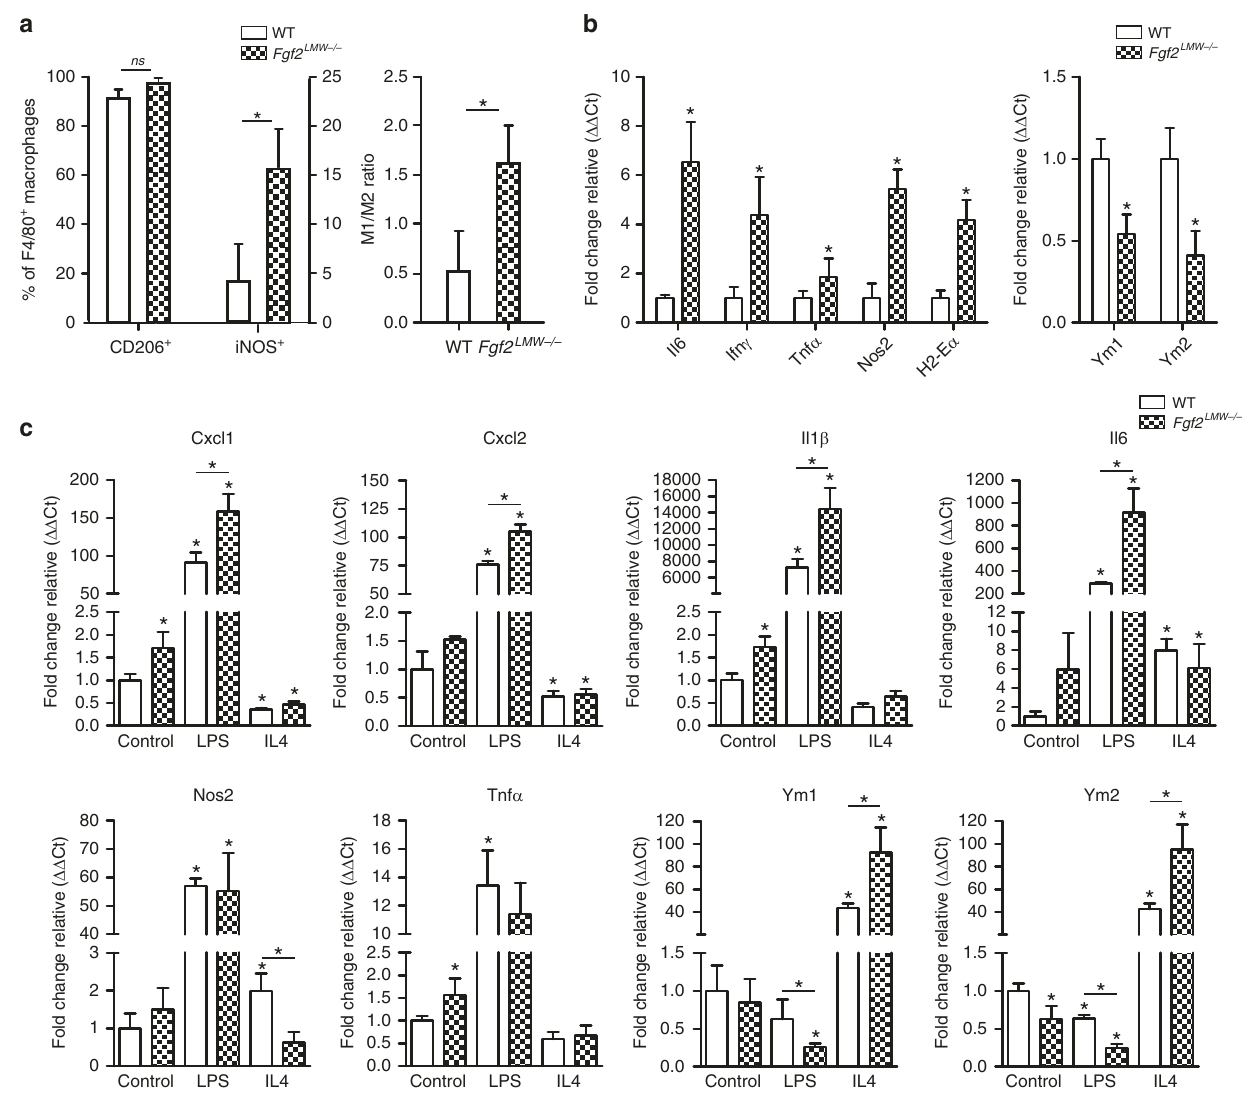
Fig. 4 Fgf2 LMW − / − macrophages are polarised towards an M1 phenotype. a Macrophage analysis of iNOS and CD206 in WT ( n = 6) and Fgf2 LMW − / − ( n = 9) mice 10 days post-tumour cell injection using fl ow cytometry. b RNA expression analysis of macrophages isolated from subcutaneous tumours of WT and Fgf2 LMW − / − mice 10 days post-tumour cell injection. c RNA expression in WT and Fgf2 LMW − / − BMDM following stimulation with LPS or IL4 using qRT- PCR analysis; Cxcl1 , Cxcl2 , Il1 β , Il6 , iNOS , Tnf α , Ym1 and Ym2 . * represents statistical signi fi cance compared with control mice ( p ≤ 0.05). Error bars